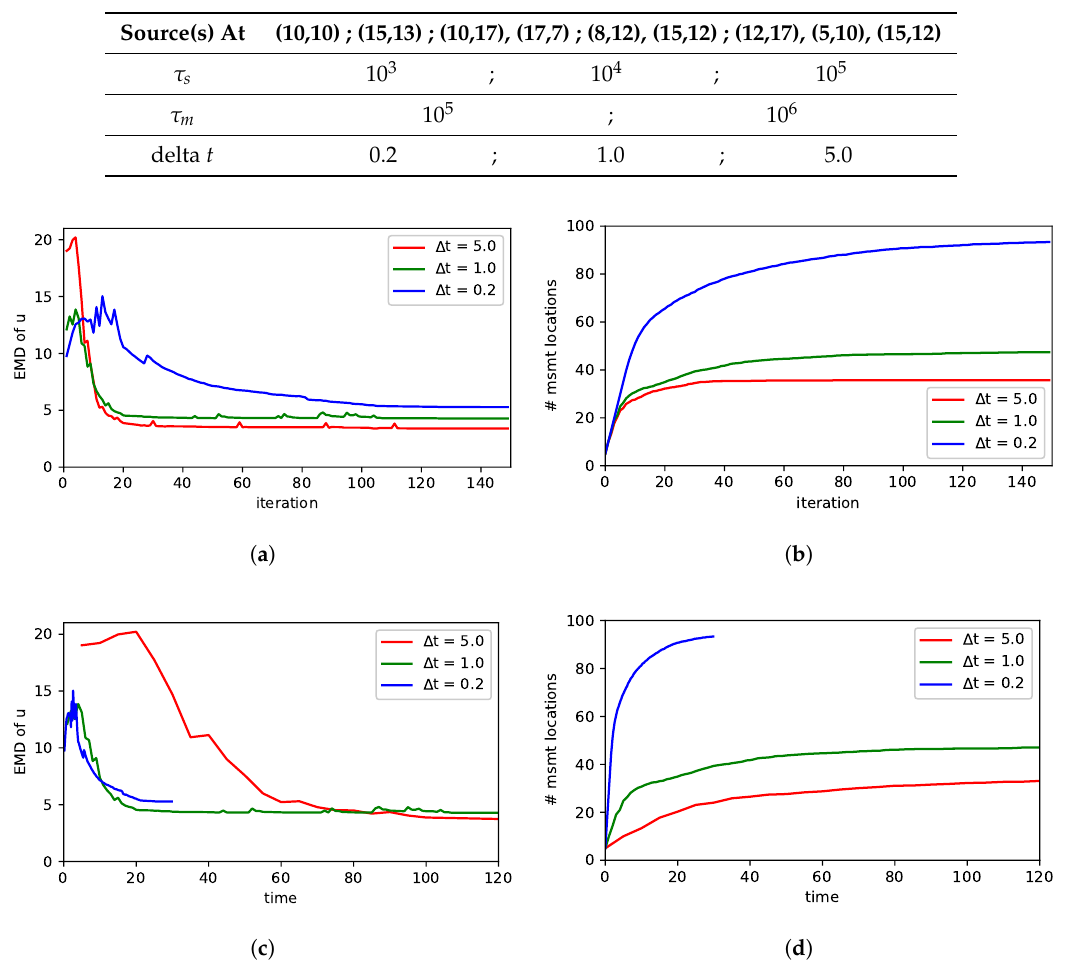
Figure 7. Comparison of different values of ∆ t , i.e., the time discretization of the PDE (note that ∆ t can be interpreted as the inverse sampling rate): The plots in ( a ) show the performance of the exploration measured by the error in the estimated source distribution by the EMD. In ( b ) the number of measurement locations is shown. Note that in each iteration 5 measurements are carried out, however measurements may be carried out at the same locations. The plots in ( c , d ) show the same data, but the x-axis is scaled according to time, not